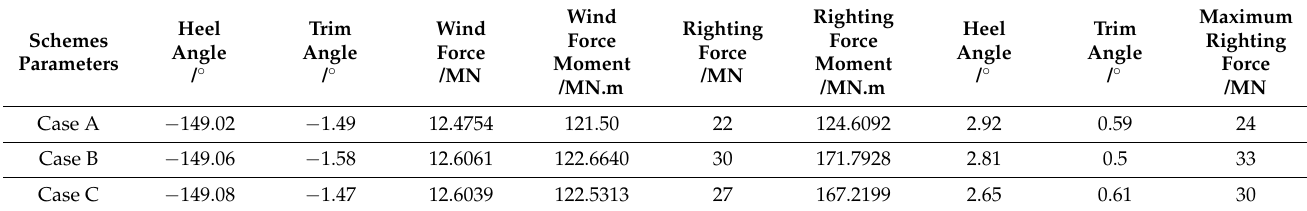
Table 3. Wind force and righting force of case II.